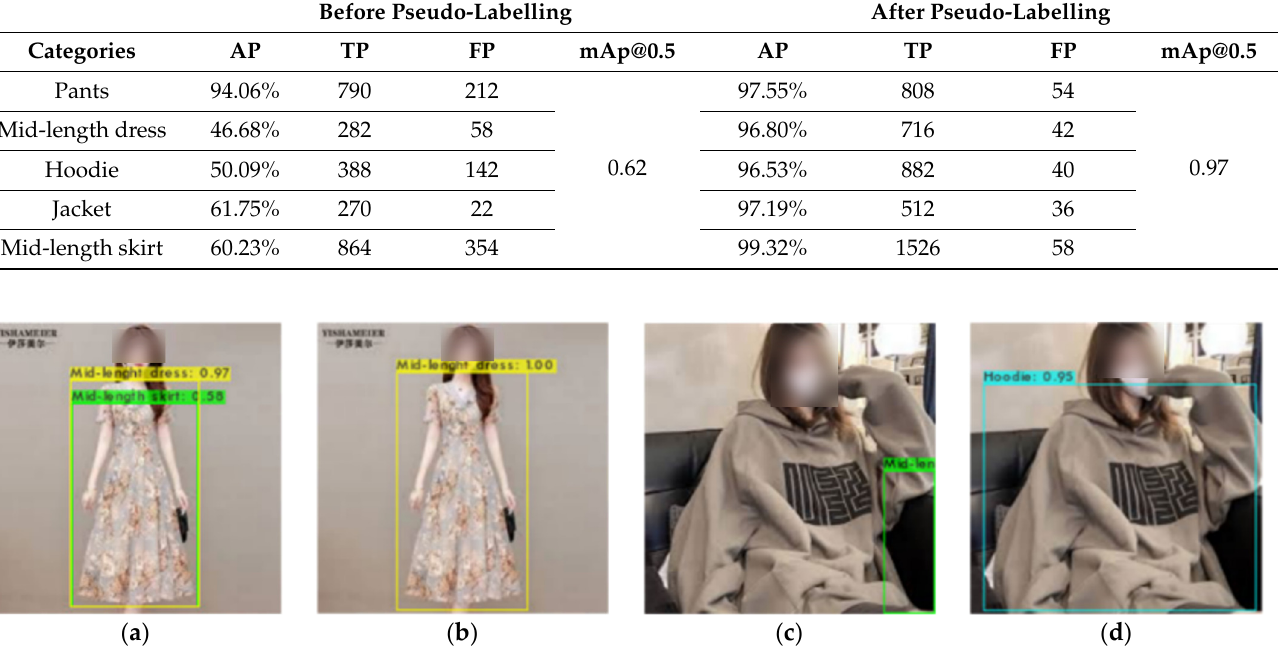
Figure 11. Detection results of before and after pseudo-labeling. ( a ) Dress Detection Result Before Pseudolabeling; ( b ) Dress Detection Result After Pseudolabeling; ( c ) Hoodie Detection Result Before Pseudolabeling; ( d ) Hoodie Detection Result After Pseudolabeling.